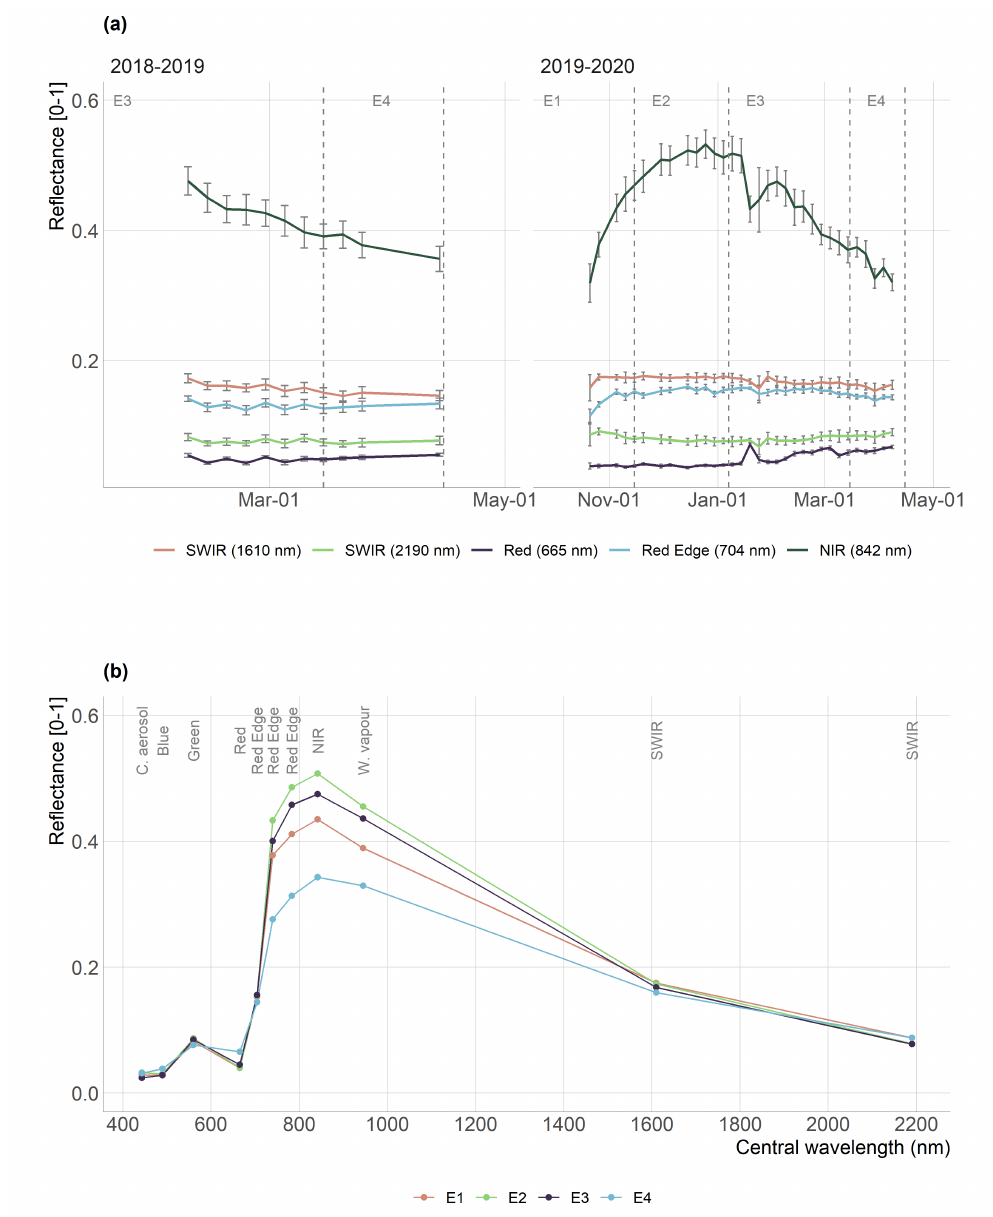
Figure 9. ( a ) Reflectivity of the spectral bands of the vegetation indices. The colored line corresponds to the average of the trees and the vertical lines to the standard deviation. ( b ) Average of the spectral signature of the trees for 5 November 2019 (E1), 5 December 2019 (E2), 3 January 2020 (E3) and 3 April 2020